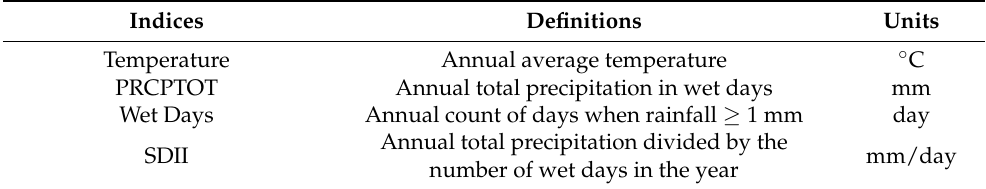
Table 1. Extreme climate